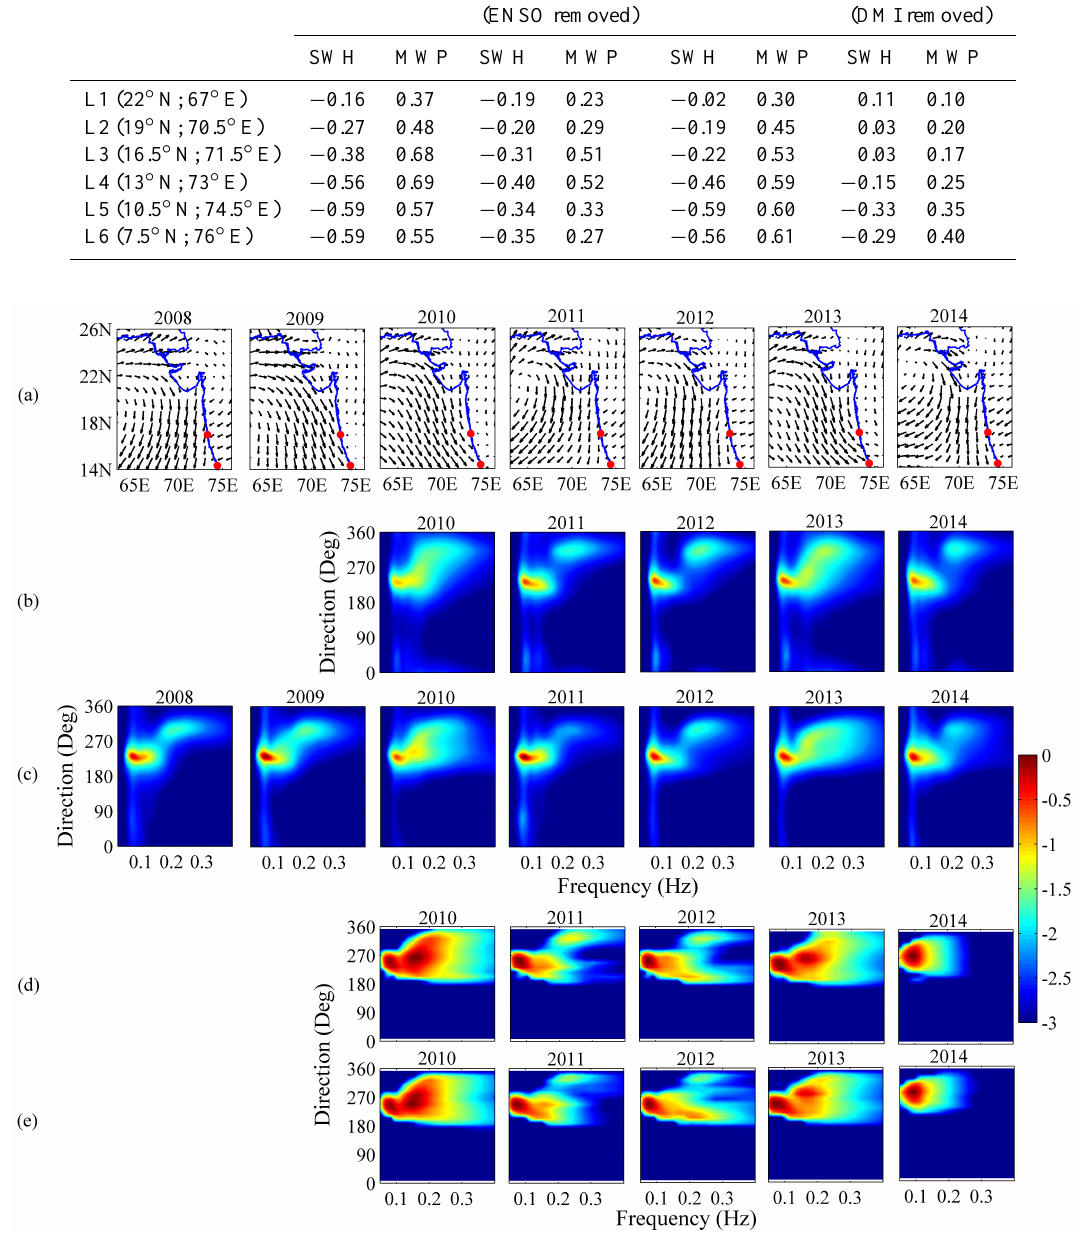
Table 1. Correlation and partial correlation of SWH and MWP with DMI and NINO3 time series during October, from 1979 to 2014. Correlation Partial correlation Correlation Partial correlation with DMI with DMI with ENSO with ENSO (ENSO removed) (DMI removed)